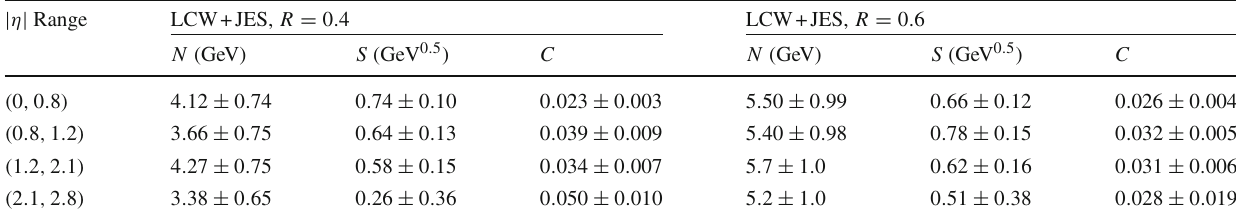
Table 7 Extracted values of the N , S , and C terms from a combined fit to the jet energy resolution measurements for R = 0 . 4 and R = 0 . 6 jets, both calibrated with the LCW+JES scheme. The uncertainties shown are highly correlated between the N , S , and C terms | η | Range LCW+JES, R = 0 . 4 LCW+JES, R = 0 .